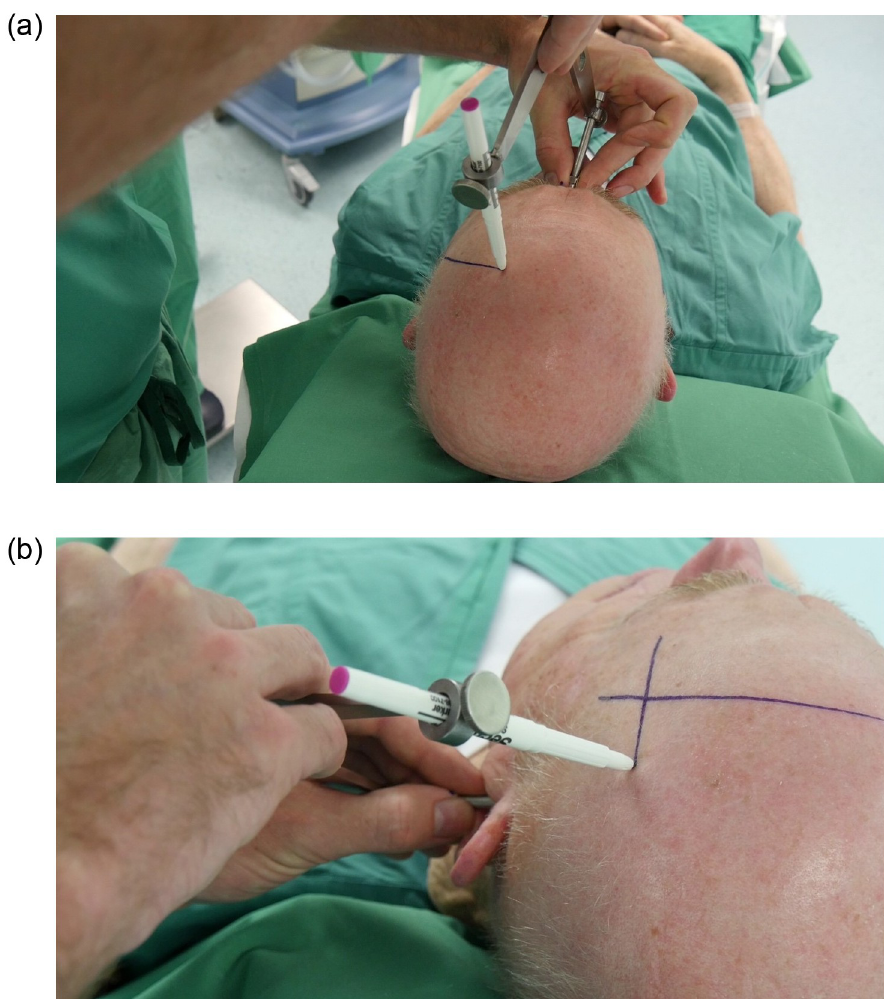
Fig 3. The distance from nasion to the target and the distance from porus to the target are marked onto the head with the help of a caliper. The individual in this manuscript has given written informed consent (as outlined in PLOS consent form) to publish these case